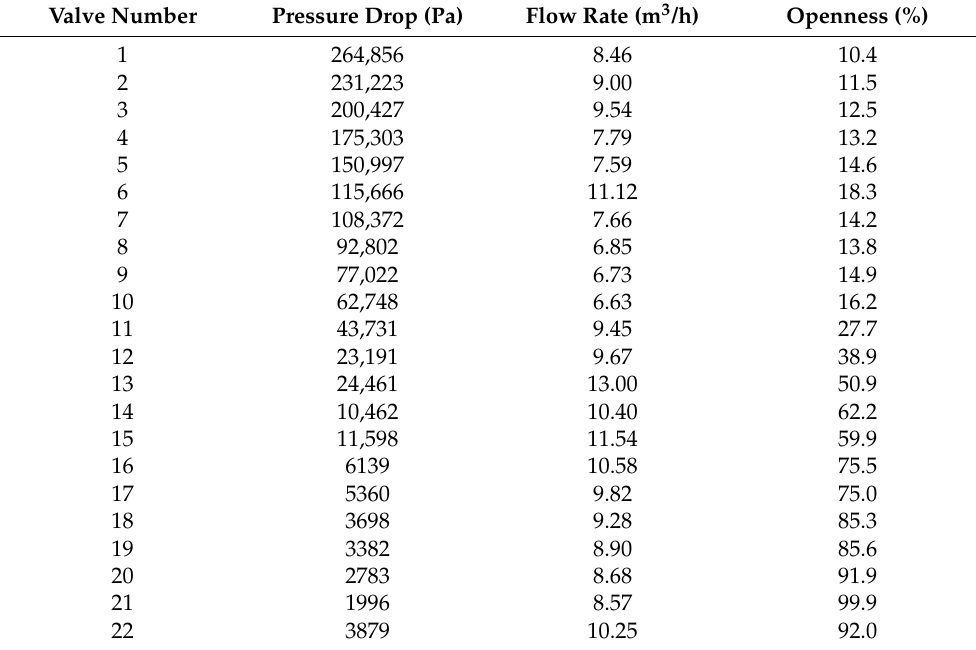
Table 2. The required pressure drops and flow rates of the throttle